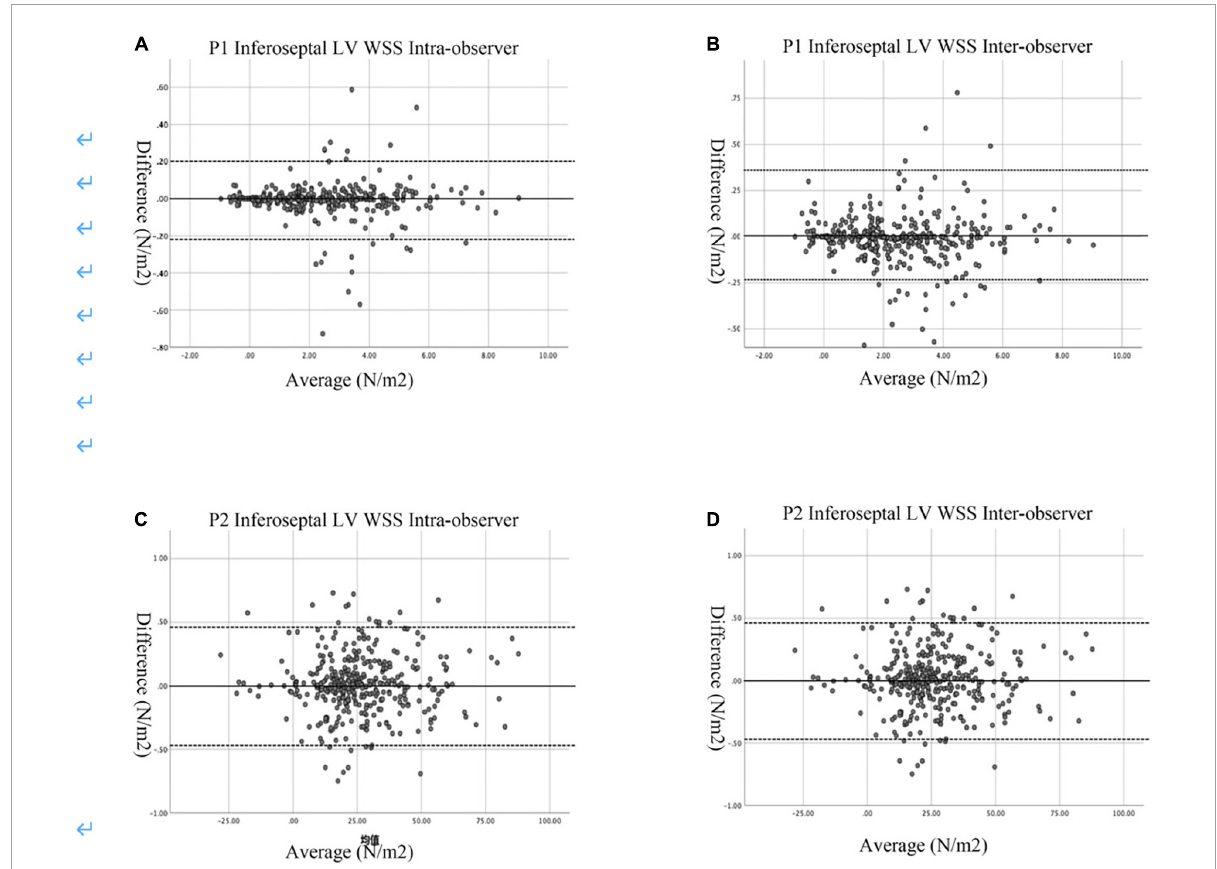
FIGURE5 Bland–Altman plots of intra- and inter-observer variability. (A) Intra-observer variability in the P1 Inferoseptal LV WSS. (B) Inter-observer variability in the P1 Inferoseptal LV WSS. (C) Intar-observer variability for the P2 Inferoseptal LV WSS. (D) Inter-observer variability for the P2 Inferoseptal LV WSS. The mean values of pairs of measurements are plotted against the difference between the measurements. The black continuous line represents the arithmetic mean and the black dotted lines represent 95% limits of